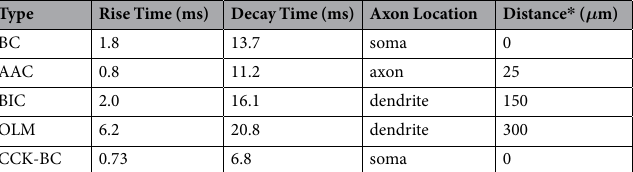
Table 1. Synaptic parameters of theta-driving neuron candidates. * Here the distance is measured from the soma of the pyramidal